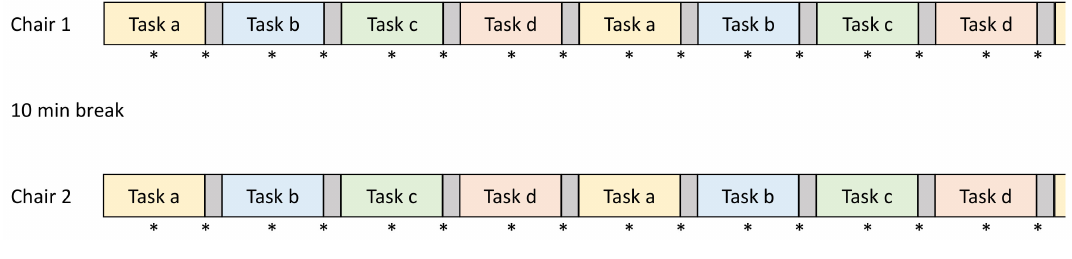
Figure 2. Overview of the measurement procedures. Each start of a kinematic and EMG (electromyography) measurement is indicated with an asterisk (*). The grey areas between two tasks indicate the 30 s period of each task transition. Tasks a to d correspond to reading, calling, typing and hand writing with the order of the tasks being